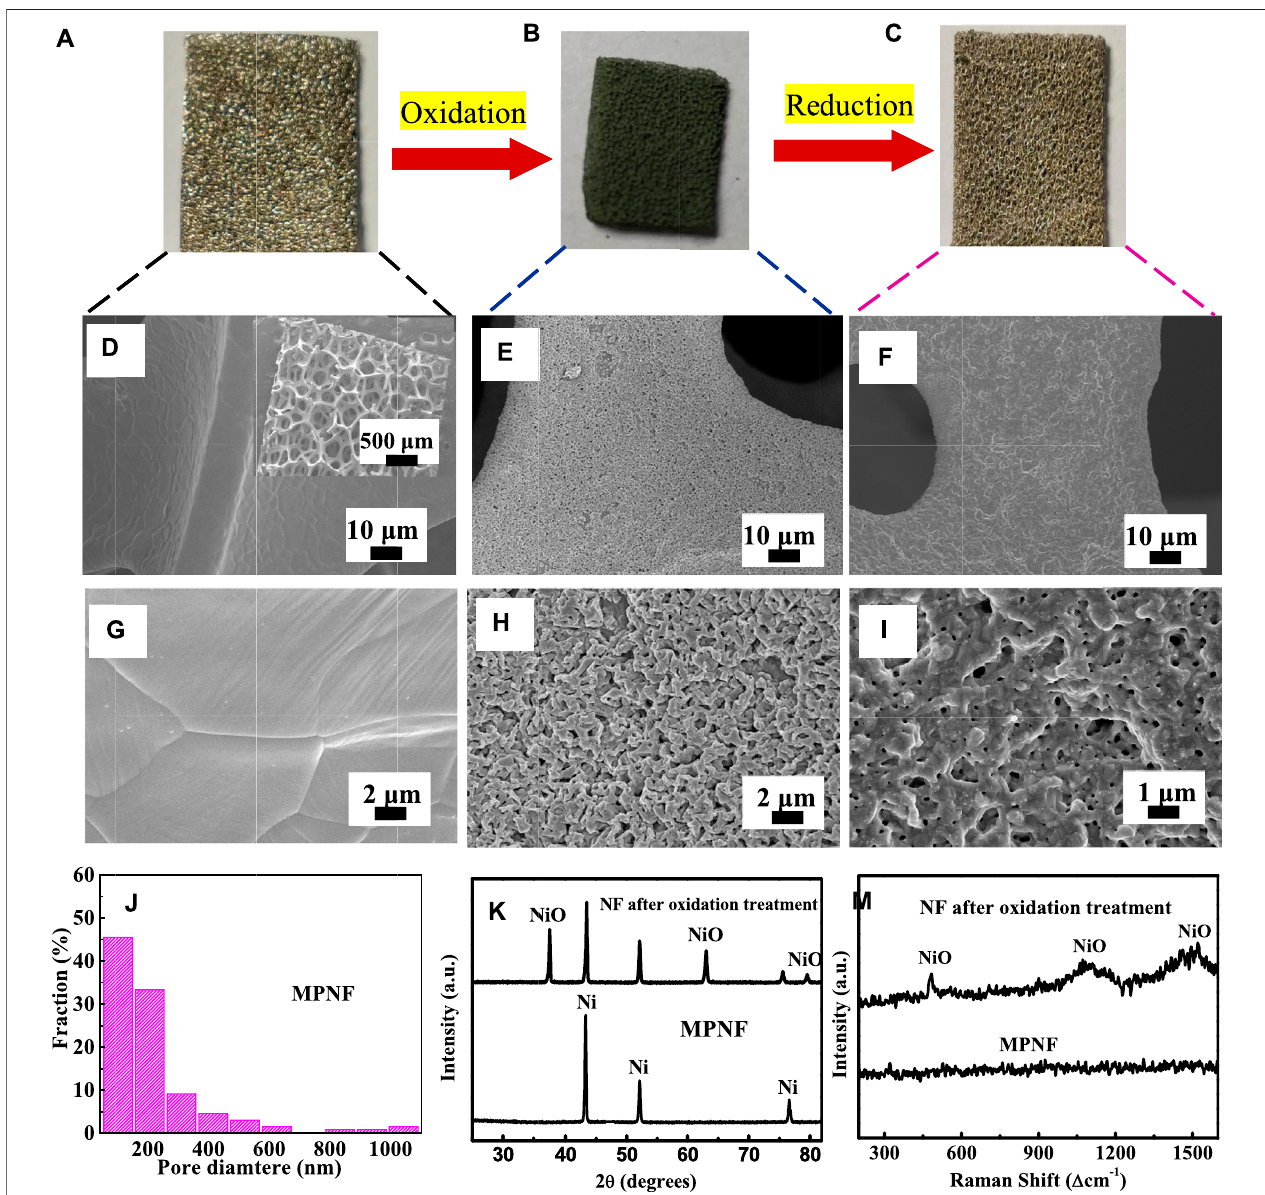
FIGURE1|(A – C) TheschemeforthefabricationofMPNF. (D,G) SEMimagesofNF, (E,H) SEMimagesofNFaftertheoxidation treatment, (F,I), andSEMimages of the fabricated MRNF. (J) Diameter distribution graph of the fabricated MRNF. (K) XRD patterns of NF after the oxidation treatment and MRNF. (M) Raman spectra of NF and